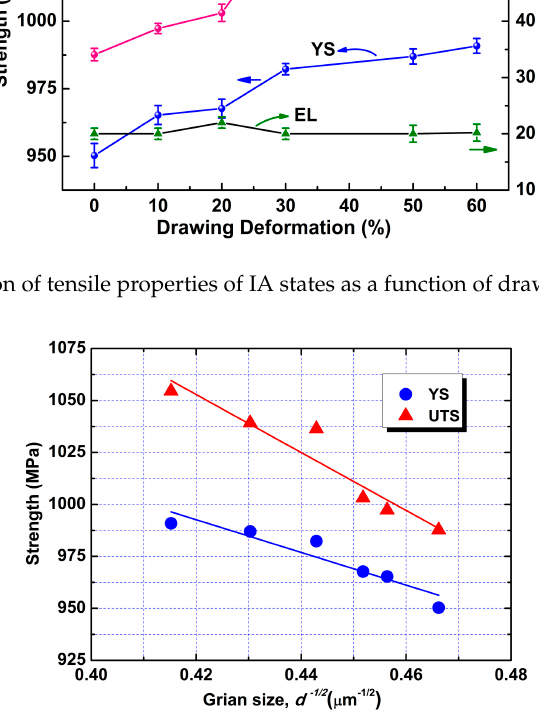
Figure 9. Yield strength (YS) and ultimate tensile strength (UTS) against grain size ( d − 1/2 ) for IA